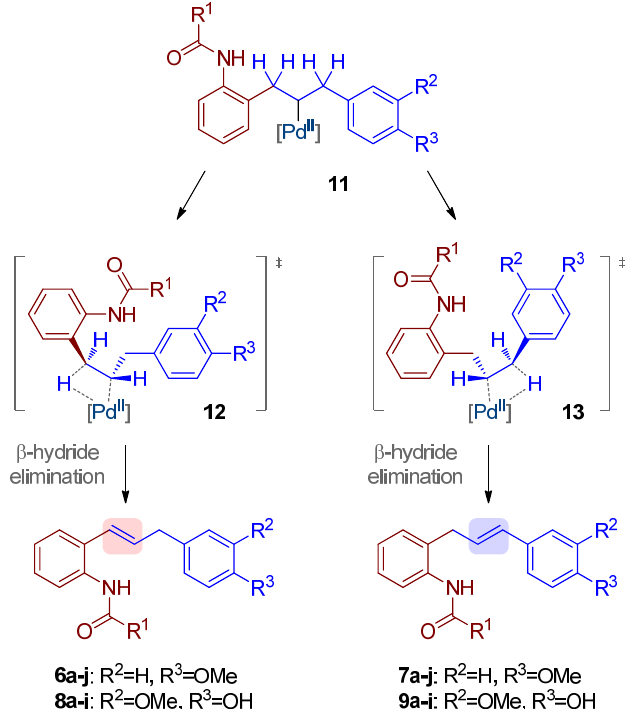
Scheme 4. Proposed transition states of the β-hydride elimination step from 11 , leading either